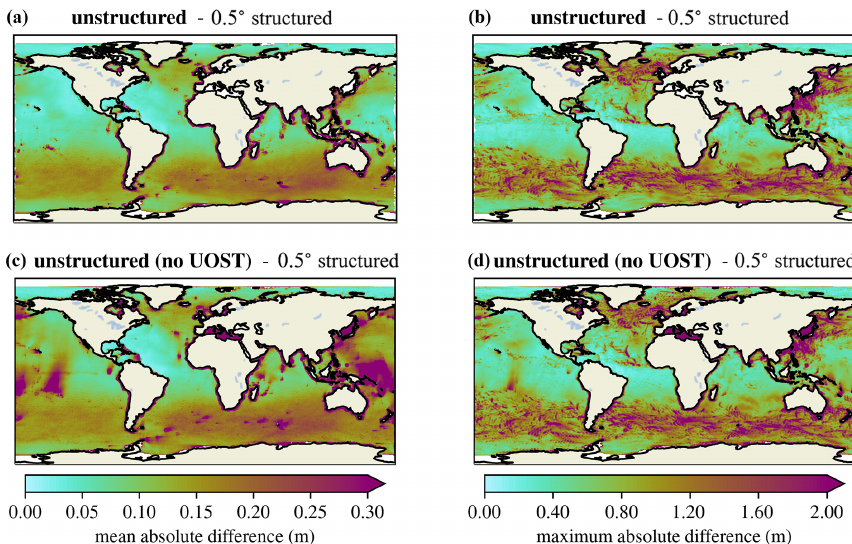
Figure 15. Mean (a, c) and maximum (b, d) absolute differences in significant wave height between the unstructured mesh with the UOST and 0.5 ◦ structured grid (a, b) and between the unstructured mesh without the UOST and 0.5 ◦ structured mesh (c, d)